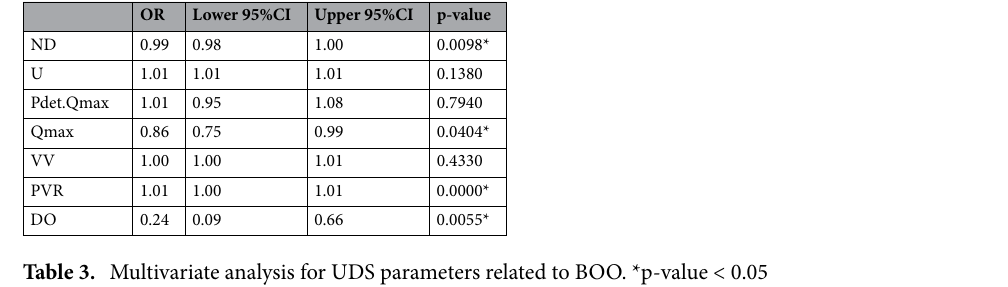
Table 3. Multivariate analysis for UDS parameters related to BOO. *p-value <